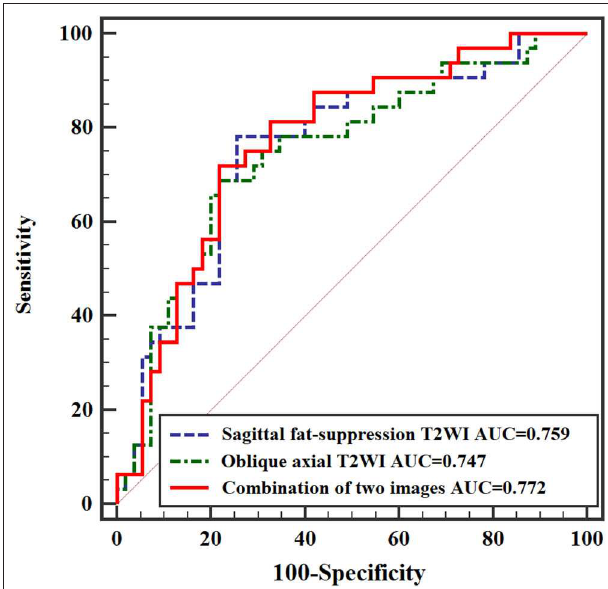
FIGURE 5 | ROC curves of independent predictors for predicting N stage.